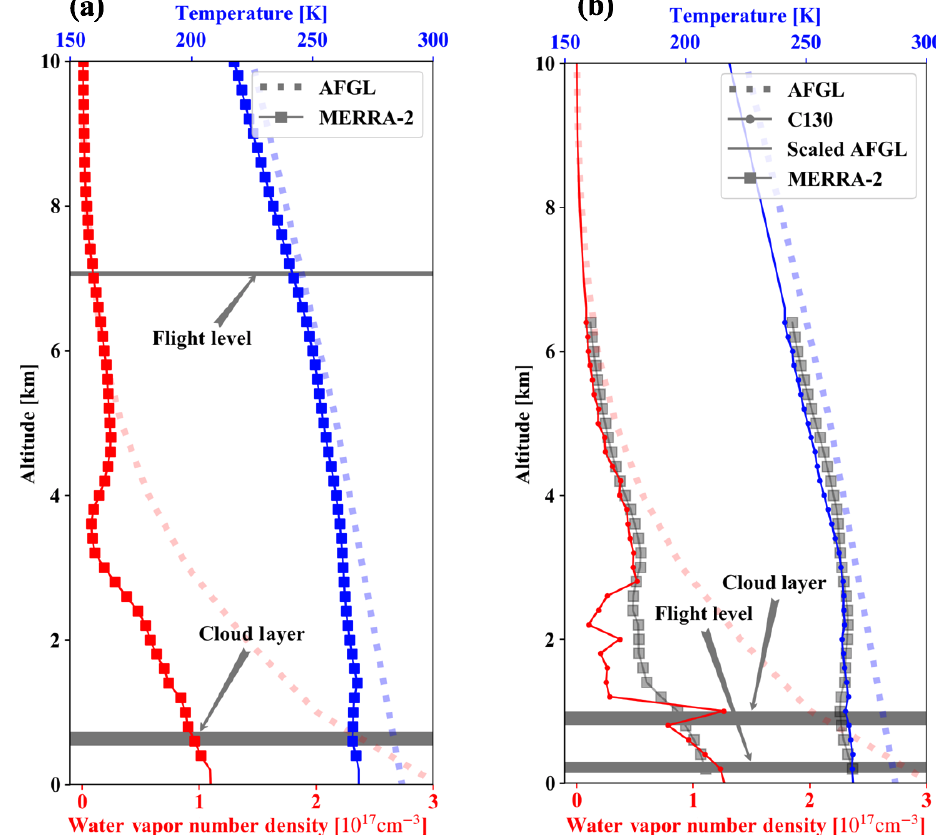
Figure 3. Vertical profiles of temperature and water vapor from MERRA-2 and from the climatology (AFGL) for (a) 11 September and (b) from the C-130 for 13 September 2014. On 11 September, MERRA-2 data at 21:00UTC were averaged over the region of 72.5 ◦ N, 74 ◦ N, 135 ◦ W, 130.625 ◦ W to represent the atmospheric profile there. The vertical cloud distribution was unavailable from the in situ data. On 13 September, aircraft data from a descending leg (19:31 to 19:50UTC at 74.1 ◦ N, 133.8 ◦ W) were used for the atmospheric profiles. Based on the water vapor profile, the cloud was likely located below 1.0km (indicated in gray). Since hygrometer measurements were not available on 11 September, the cloud top height (1.1km) was obtained from the MODIS L2 product) and the geometric thickness was set to 0.2km (just like on 13 September). The flight level range is also shown. The solid lines for both days represent the temperature and water vapor profiles that went into the radiative transfer